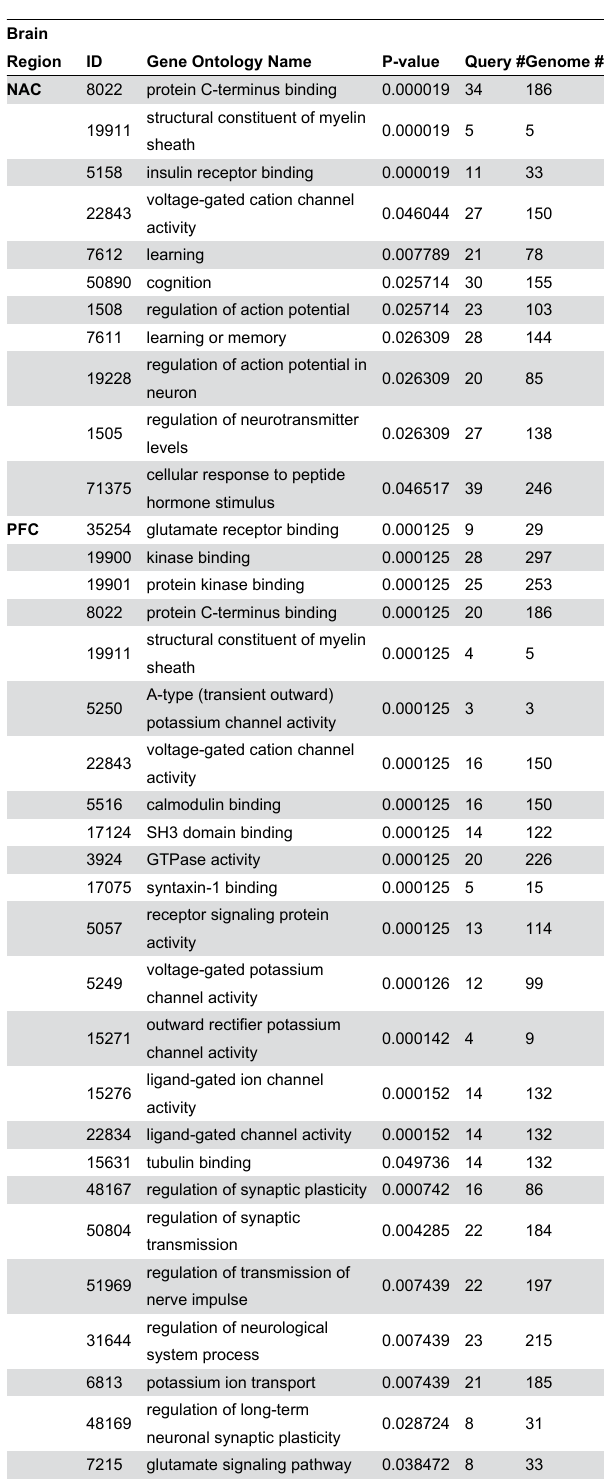
Table 1. Gene Ontology Over-Representation Analysis of Basal Gene